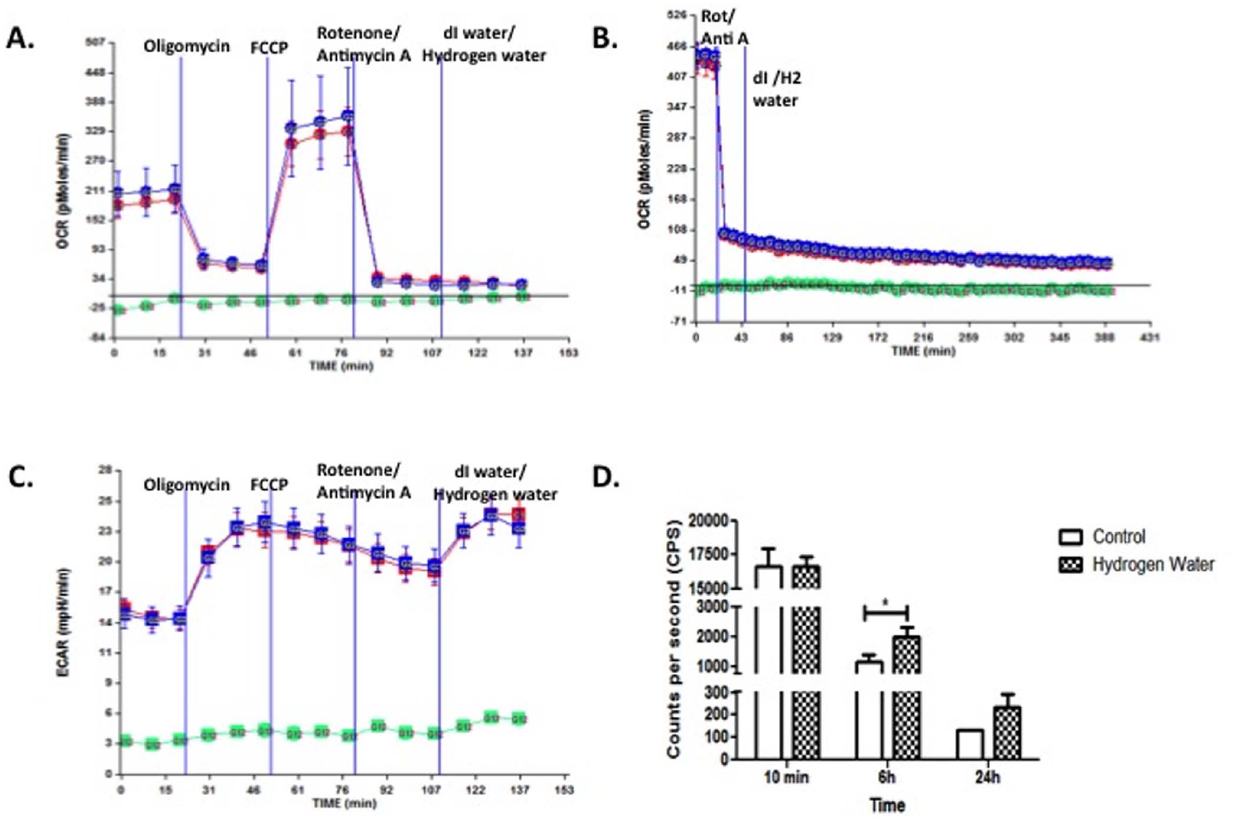
Figure 11. Treatment with Molecular Hydrogen Does Not Rescue Respiration After ETC Inhibition. ImBPCs were subjected to a mitochondrial stress test in the presence of the ATP synthase inhibitor (oligomycin; 3 m M), the uncoupling agent (FCCP; 3 m M), the complex I inhibitor (rotenone; 3 m M), and the complex III inhibitor (antimycin A; 1.5 m M). Once respiration was inhibited, ImBPCs were exposed to hydrogen water (red) or control (dI water; blue), and OCR was measured for 30 min (Panel A) or 6 h (Panel B). ECAR was also examined for 30 min (Panel C). ATP levels were measured after 10 min, 6 h, or 24 h of treatment with molecular hydrogen water. Results presented here are from one experiment completed, which is representative of the 3 experiments that were done. Results are represented as a mean 6 SEM. ** is p , 0.01 and *** is p , 0.001.